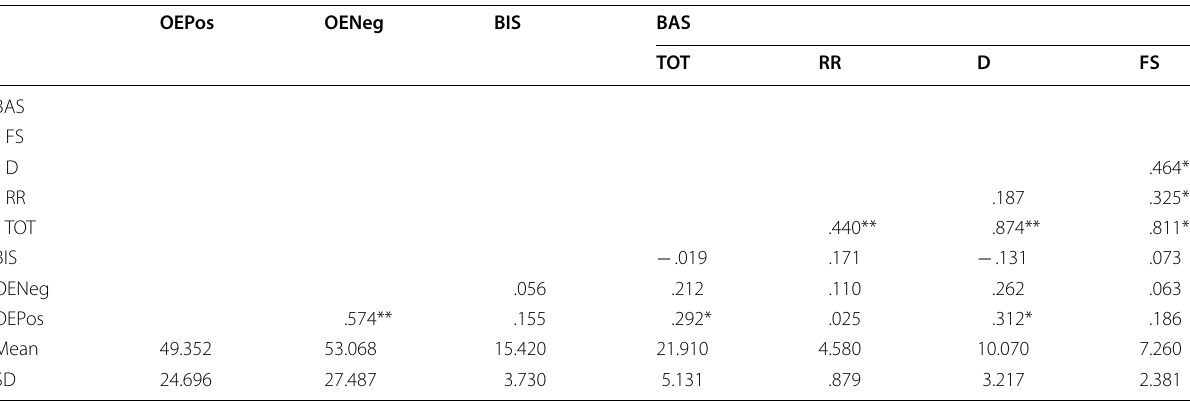
Table 1 Correlation matrix showing relationships between BIS Total, BAS Total, BAS subscales, and overestimation bias